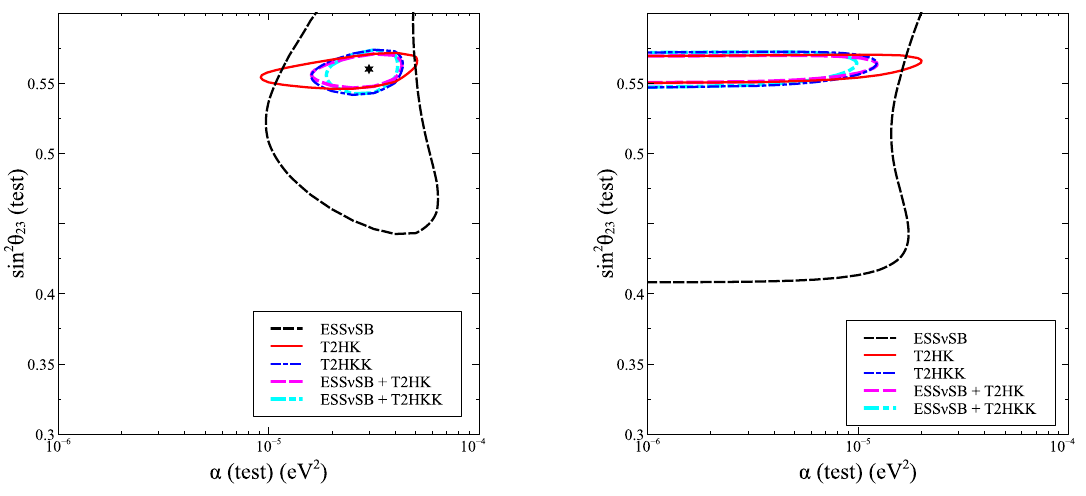
Figure 12 . The 95 % confidence contours in the θ 23 - α plane for various combination of experiments. The left panel is for the case where α = 3 × 10 − 5 (eV 2 ) is assumed for the data and the right panel is for the case where α = 0 in the decay. The black dashed curves are for ESS ν SB, red solid curves are for T2HK, blue dashed-dotted curves for T2HKK, the magenta dashed for combination of ESS ν SB and T2HK and the cyan curves are for combination of ESS ν SB and